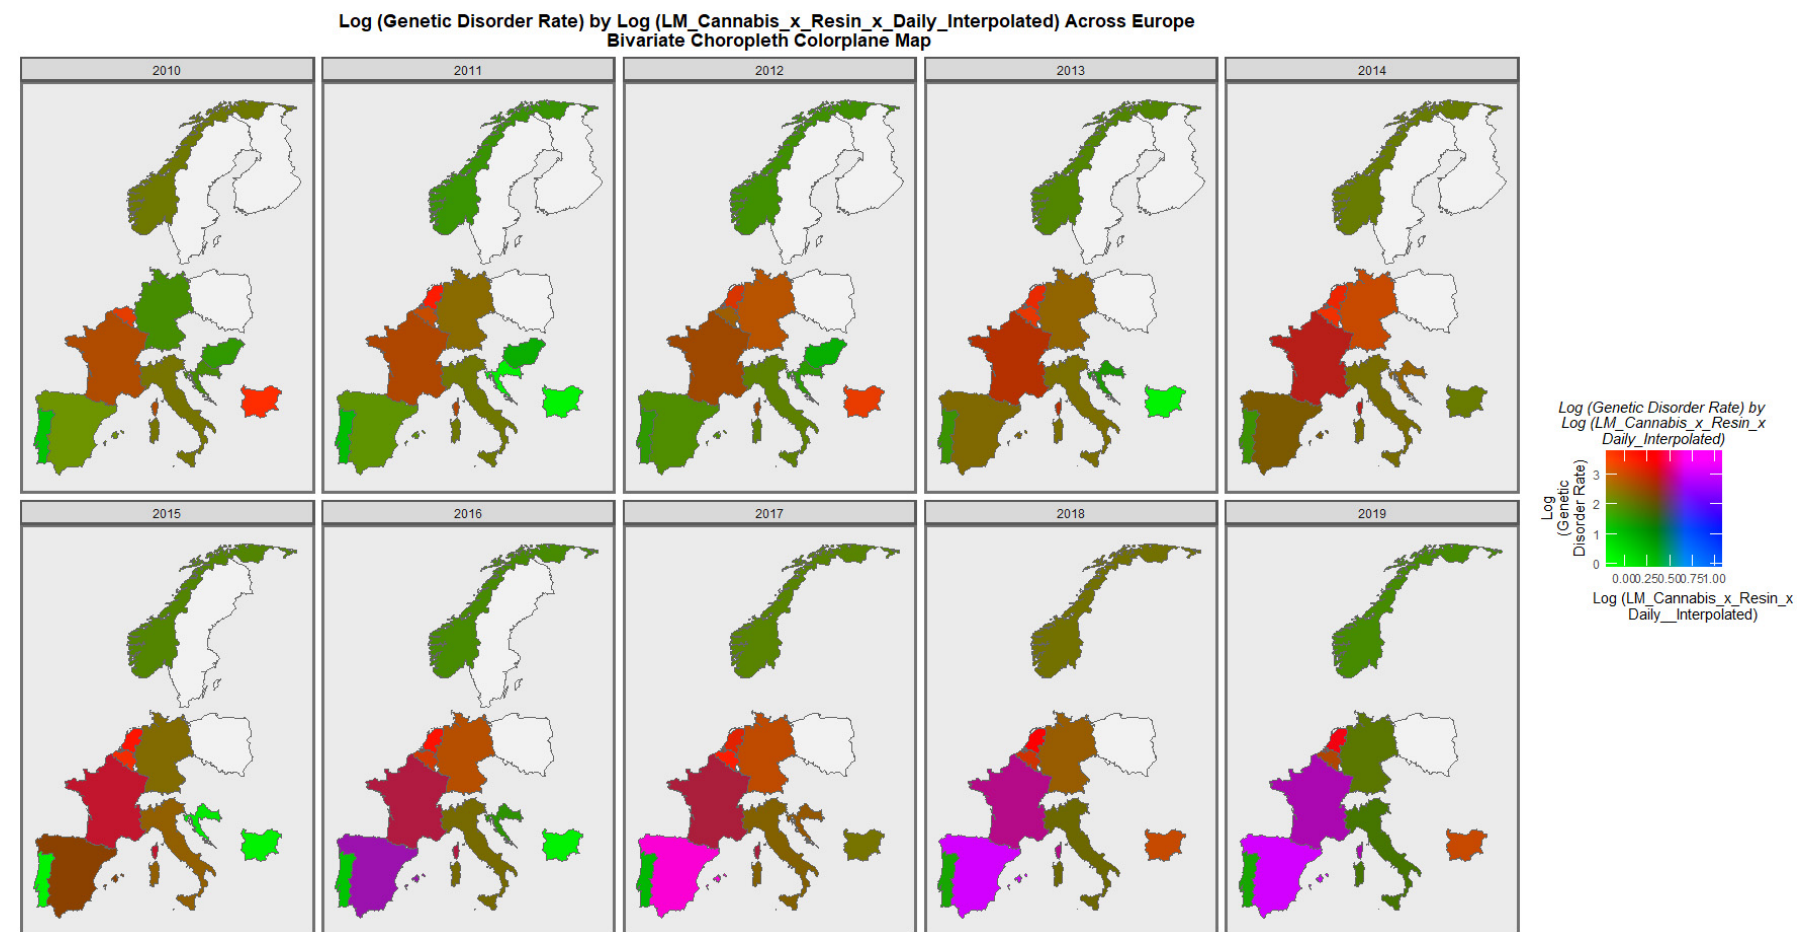
Figure 7. Bivariate choropleth sequential map-graph of log (genetic disorder rates) by last month cannabis use: cannabis resin THC concentration: daily cannabis use interpolated over time in selected European nations 2010–2019.